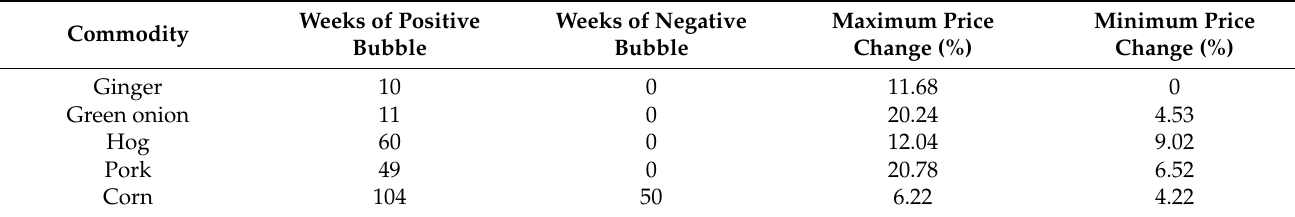
Table 4. The properties and fluctuations of agricultural commodity price